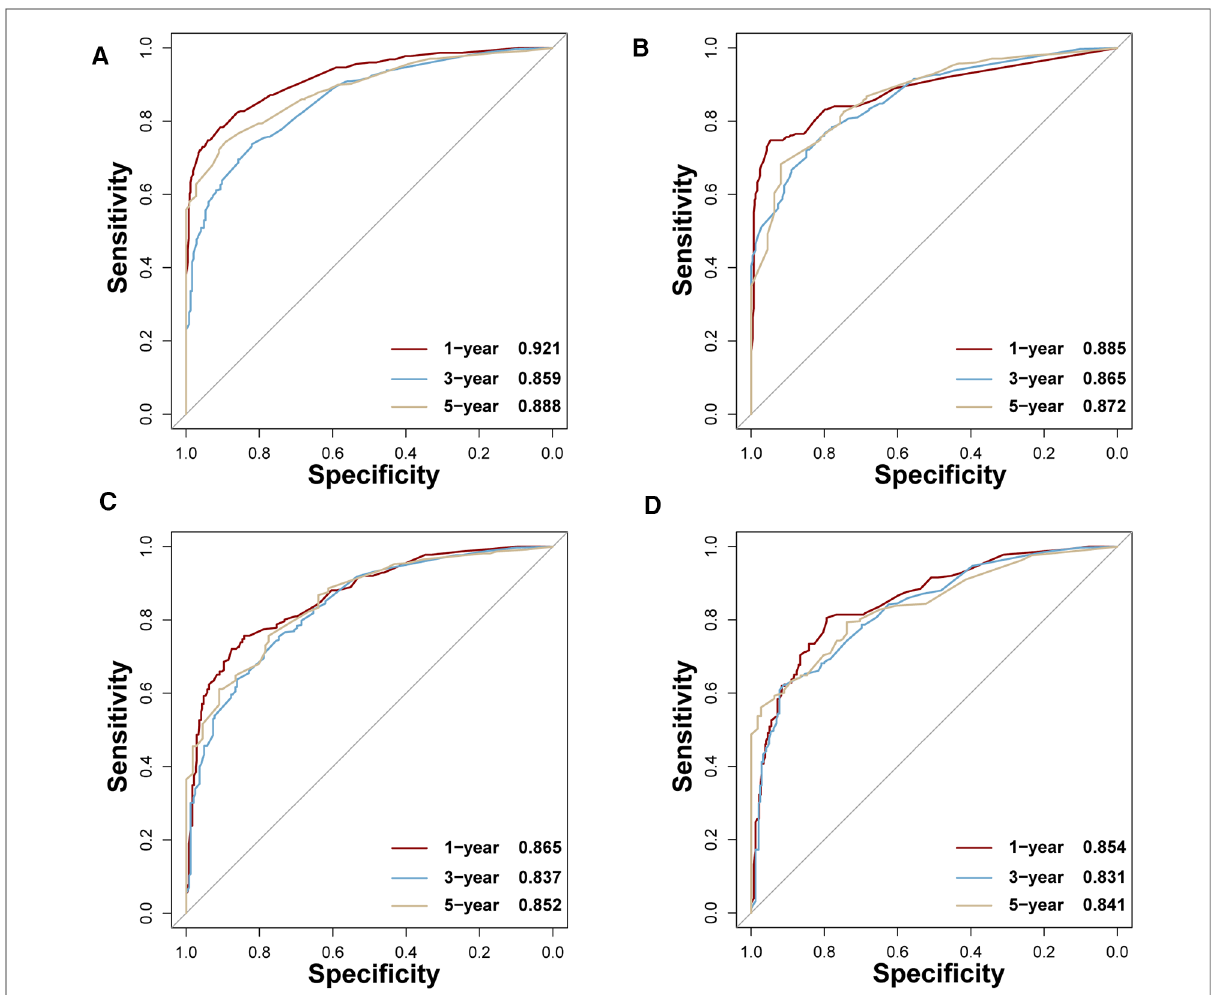
FIGURE 4 AUCs of four ML-based models for the training set at 1-, 3-, and 5-year points. ( A ) BP-ANN, ( B ) RF, ( C ) SVM, ( D )